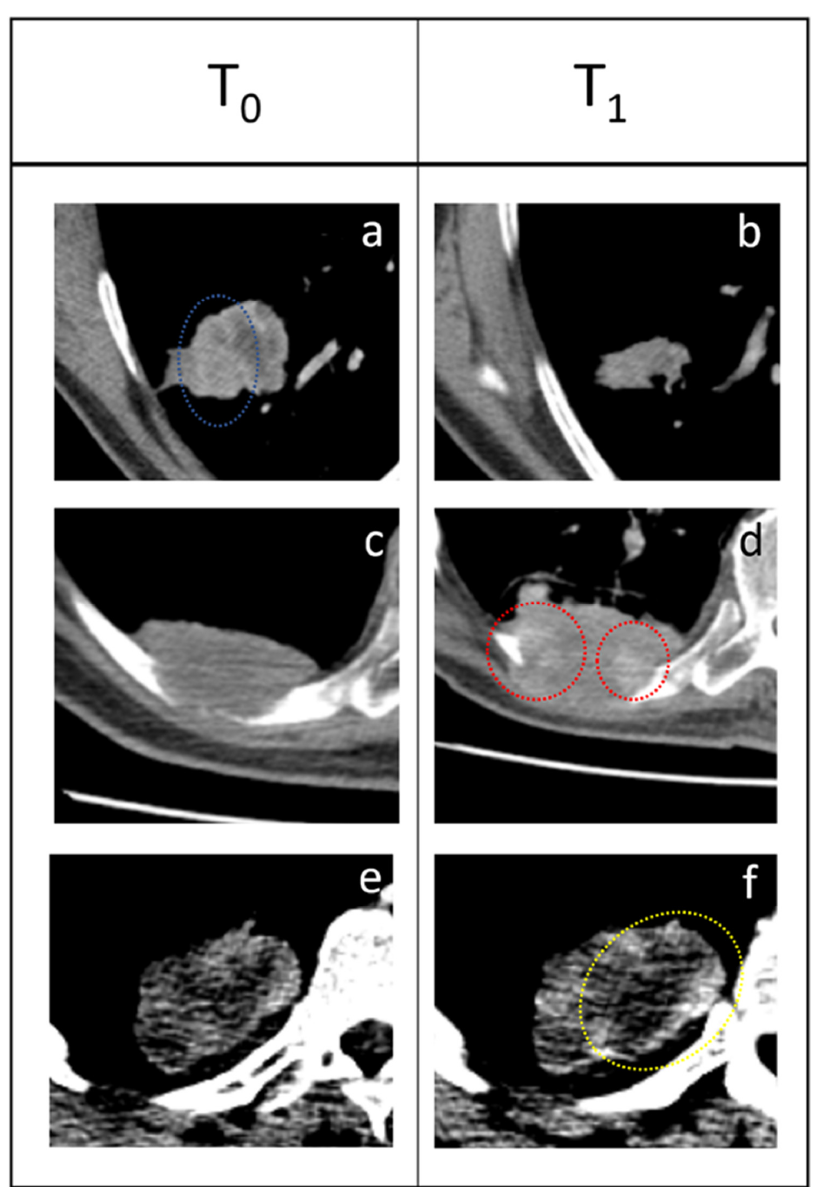
Figure 3. Three examples of response to immunotherapy. ( a , b ) PR: the tumor shrunk from T0 to T1 and areas that presented high enhancement (blue dotted circle) disappeared. ( c , d ) SD: 63-year-old male patient presenting a pulmonary tumor that penetrates the thoracic wall and erodes a rib with extensive bone reabsorption. The first re-evaluation showed an increased mass (53 × 35 mm vs. 50 × 25 mm) consistent with PD. However, during therapy, the lesion gradually reduced and became stable. Delta-radiomics individuated an extreme negative variation of LAHGLE (−0.999770105) that could be represented by the emergence of areas with vivid contrast media uptake (red dotted circles) within the lesion. ( e , f ) PD: this pulmonary lesion was slightly enlarged at the first follow-up but radiomic revealed an increase in LALGLE ( − 0.173288587). The lesion kept growing in the following months, a finding consistent with PD. This case represents a good example of how radiomics could intercept changes in the radiological images that are almost invisible to the human eye and predict the evolution of each lesion. The slight increase of LALGLE could be referred to as the slight enlargement of the central hypodense area (yellow dotted circle). In this case, the CT window was stressed for demonstrative